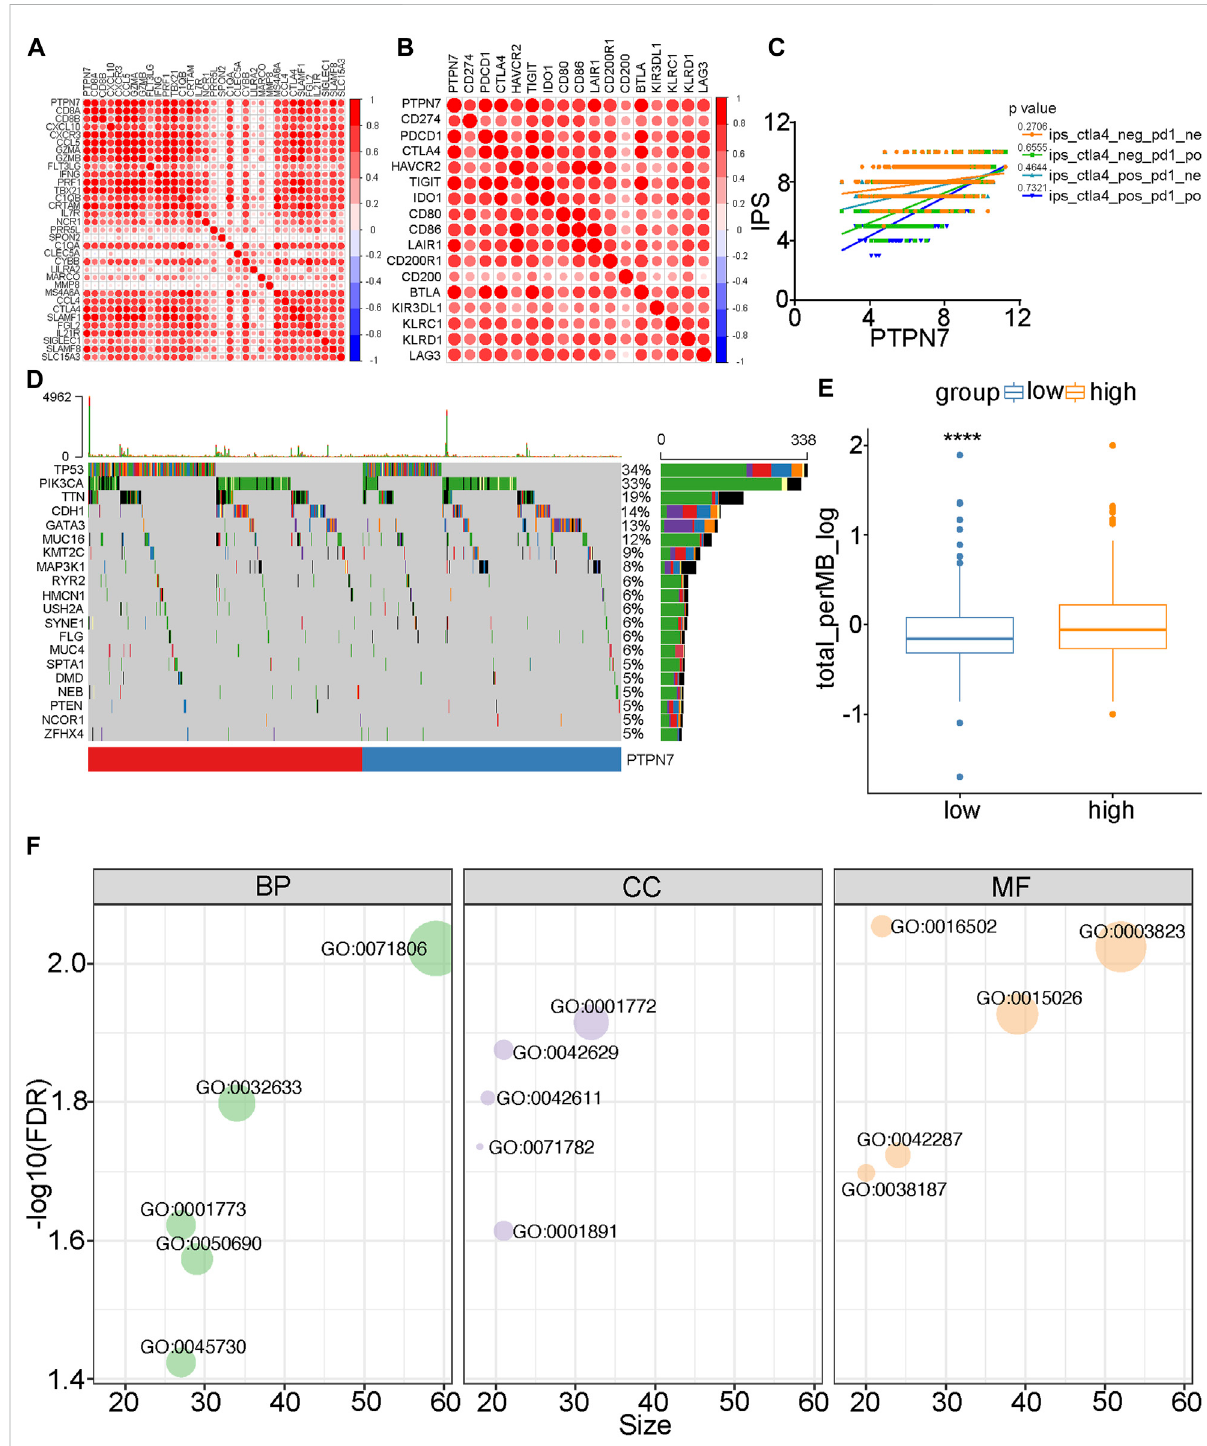
FIGURE 4 Immuno-correlations between PTPN7 in BrCa and its functions. (A) Correlations between PTPN7 and gene markers for immune cells. (B) Correlationsbetween PTPN7 andcommoninhibitory immune checkpoints. (C) The differentPTPN7expressionthat theIPS are existing infour types which is pd1&ctla4 positive or negative. (D) Mutational pro fi les of commone genes in the different PTPN7 expression group in the TCGA cohort. (E) Comparison of PTPN7 expression in high and low PTPN7 groups. (F) GO analysis of PTPN7 in BrCa based on the Linked Omics